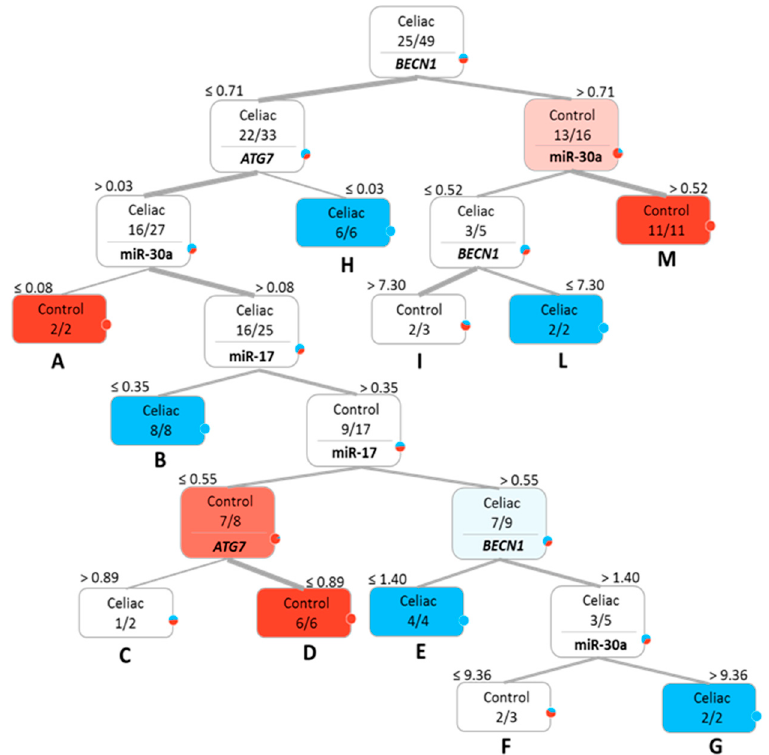
Figure 3. Classification tree obtained using the relative quantitative expression values (numbers over each box) of the analyzed genes ( ATG7 and BECN1 ) and miRNAs (miR-17 and miR-30a) in intestinal biopsies. CD patients are indicated in blue, controls in red. Color tonalities are related to the composition of each subgroup. Resulting subgroups are highlighted by capital letters.